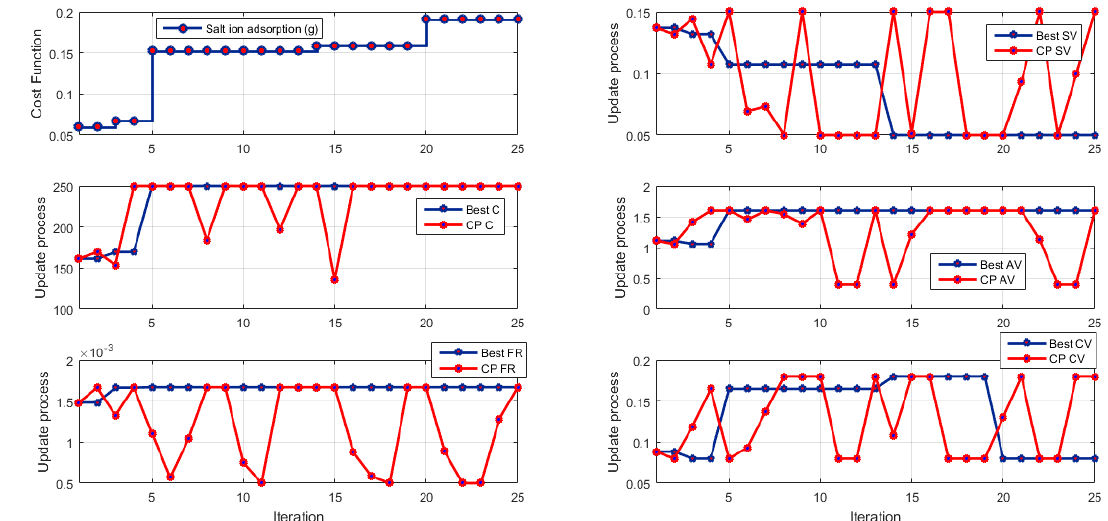
Figure 8. The cost function variation, best values of decision variables during the optimization process of salt ion adsorption. C is the capacitance, CP is the center point, FR is the flow rate, SV is the spacer volume, AV is the applied voltage, and CV is the cell volume.